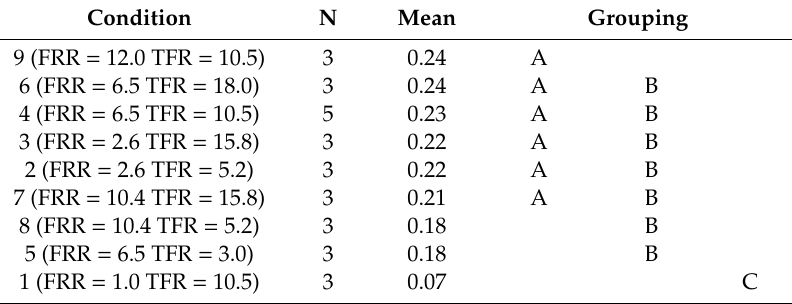
Table 3. Grouping information using the Tukey method at a 95% confidence level.